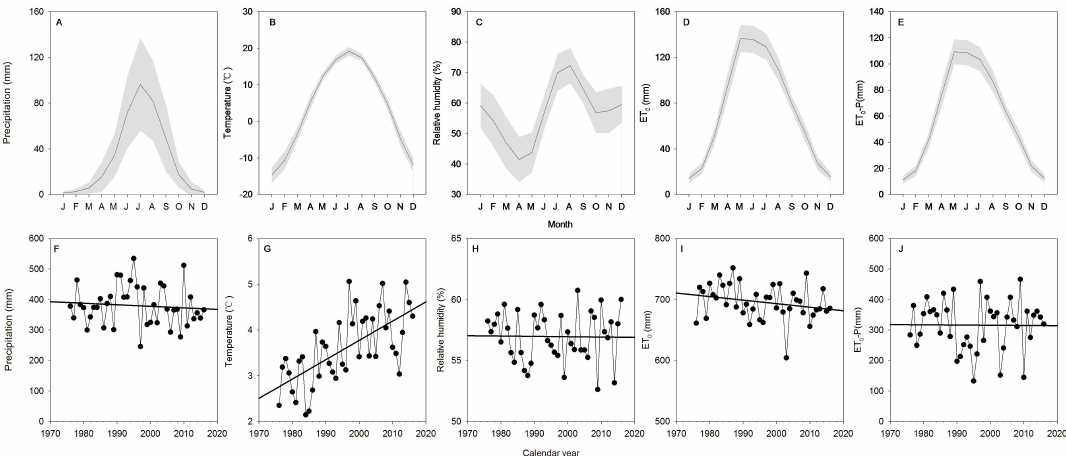
Figure 2. Variations in mean precipitation ( A ), temperature ( B ), relative humidity ( C ), potential evapotranspiration (ET 0 ) ( D ), and water balance (ET 0 -P) ( E ) at a monthly timescale from 1976 to 2016. Also shown are variations in precipitation ( F ), temperature ( G ), relative humidity ( H ), ET 0 ( I ), and ET 0 -P ( J ) during poplar tree growth.